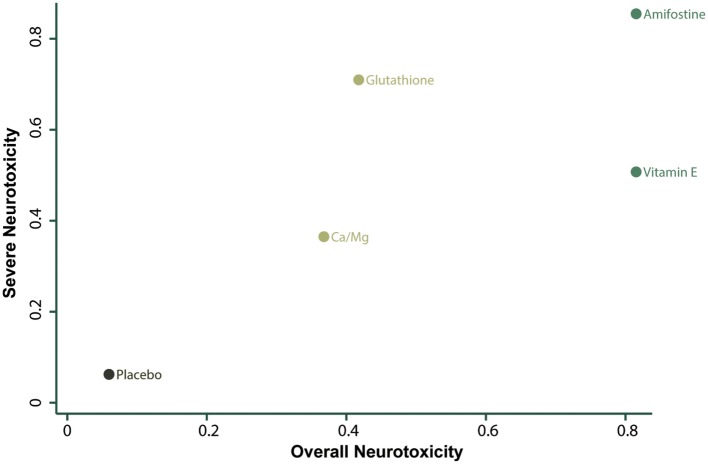
Cluster analysis.